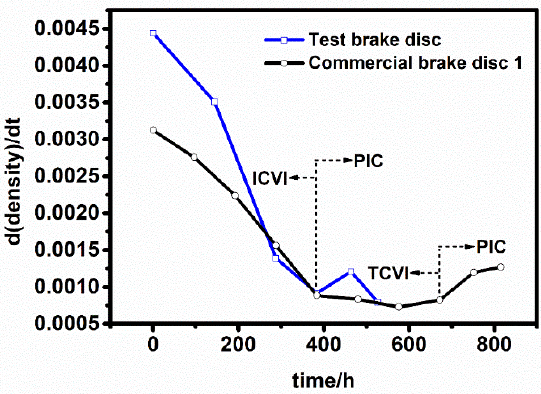
Figure 3. Densification rates of the test brake disc and commercial brake disc 1 over time.